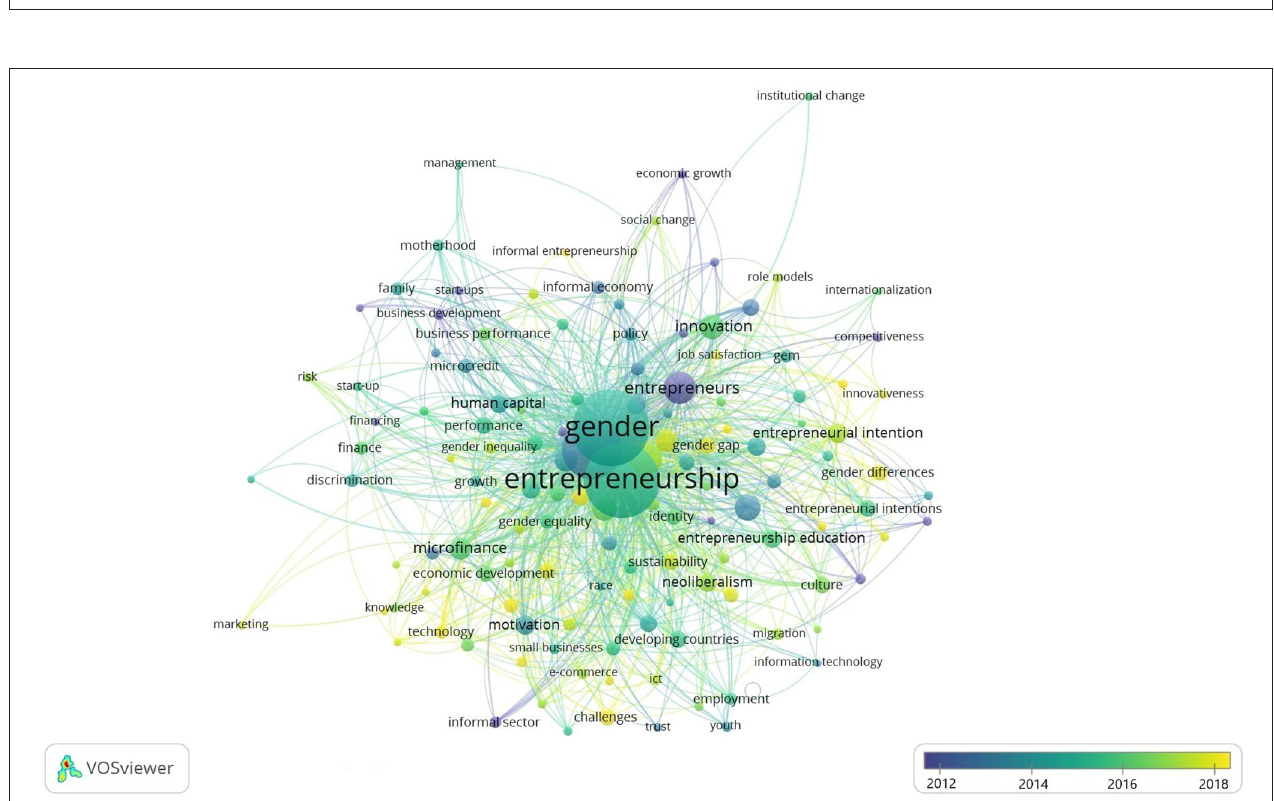
FIGURE 3 | Temporal overlay on a keyword co-word occurrence map for women entrepreneurship articles.